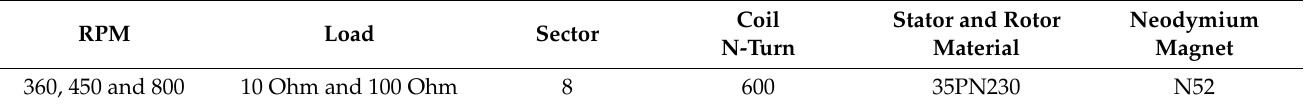
Table 4. Key simulation